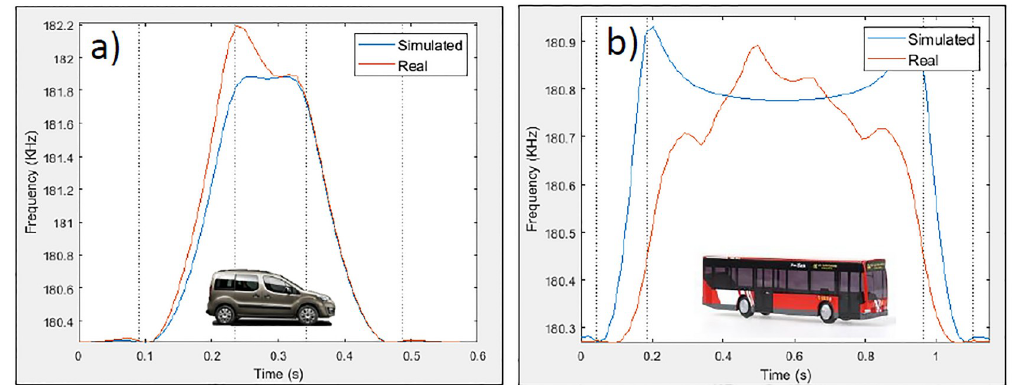
Fig 3. Differences between simulated and real magnetic profiles. (a) Simulated and real magnetic profile—Van. (b) Simulated and real magnetic profile—Bus.